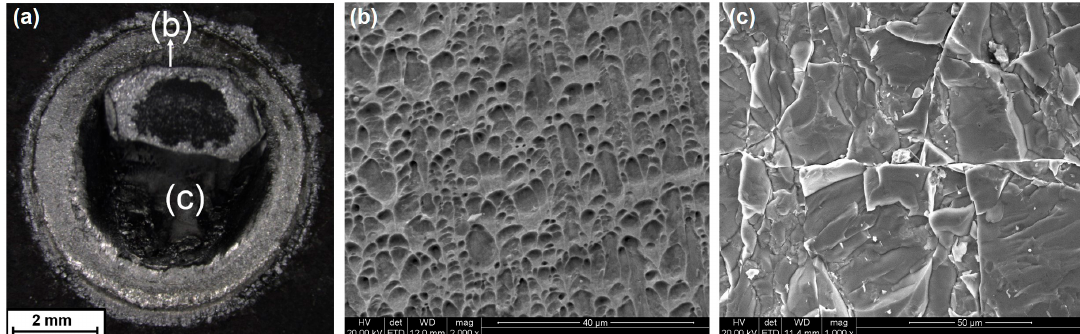
Figure 10. Microstructure of the fracture of PF I: ( a ) overall view; ( b ) zone (b) in ( a ) with dimple-like ductile fracture characteristics; ( c ) zone (c) in ( a ) with rive pattern cleavage fracture characteristics.